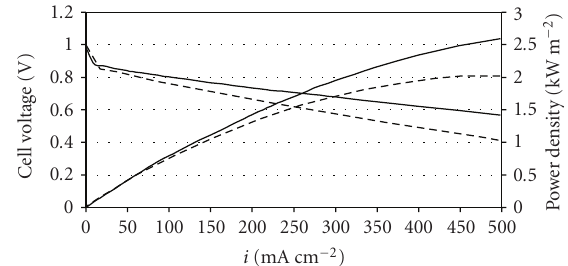
Figure 6: Cell voltage and power density versus current density plot for MEA with Nafion 112 (---) and Nafion/MMT ( bold continuous lines) at 50 ◦ C after 600 hours at low